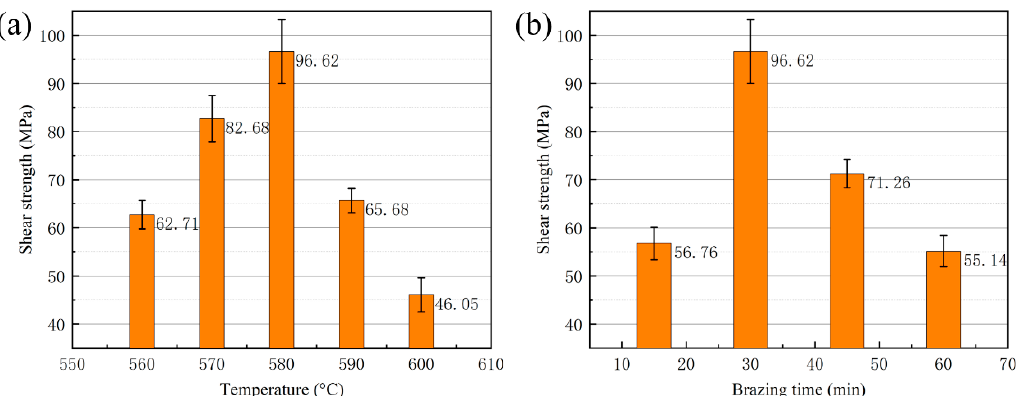
Figure 10. Shear strength of brazed joint as a function of ( a ) brazing temperature with constant brazing time of 30 min; ( b ) brazing time with constant brazing temperature 580 °C.